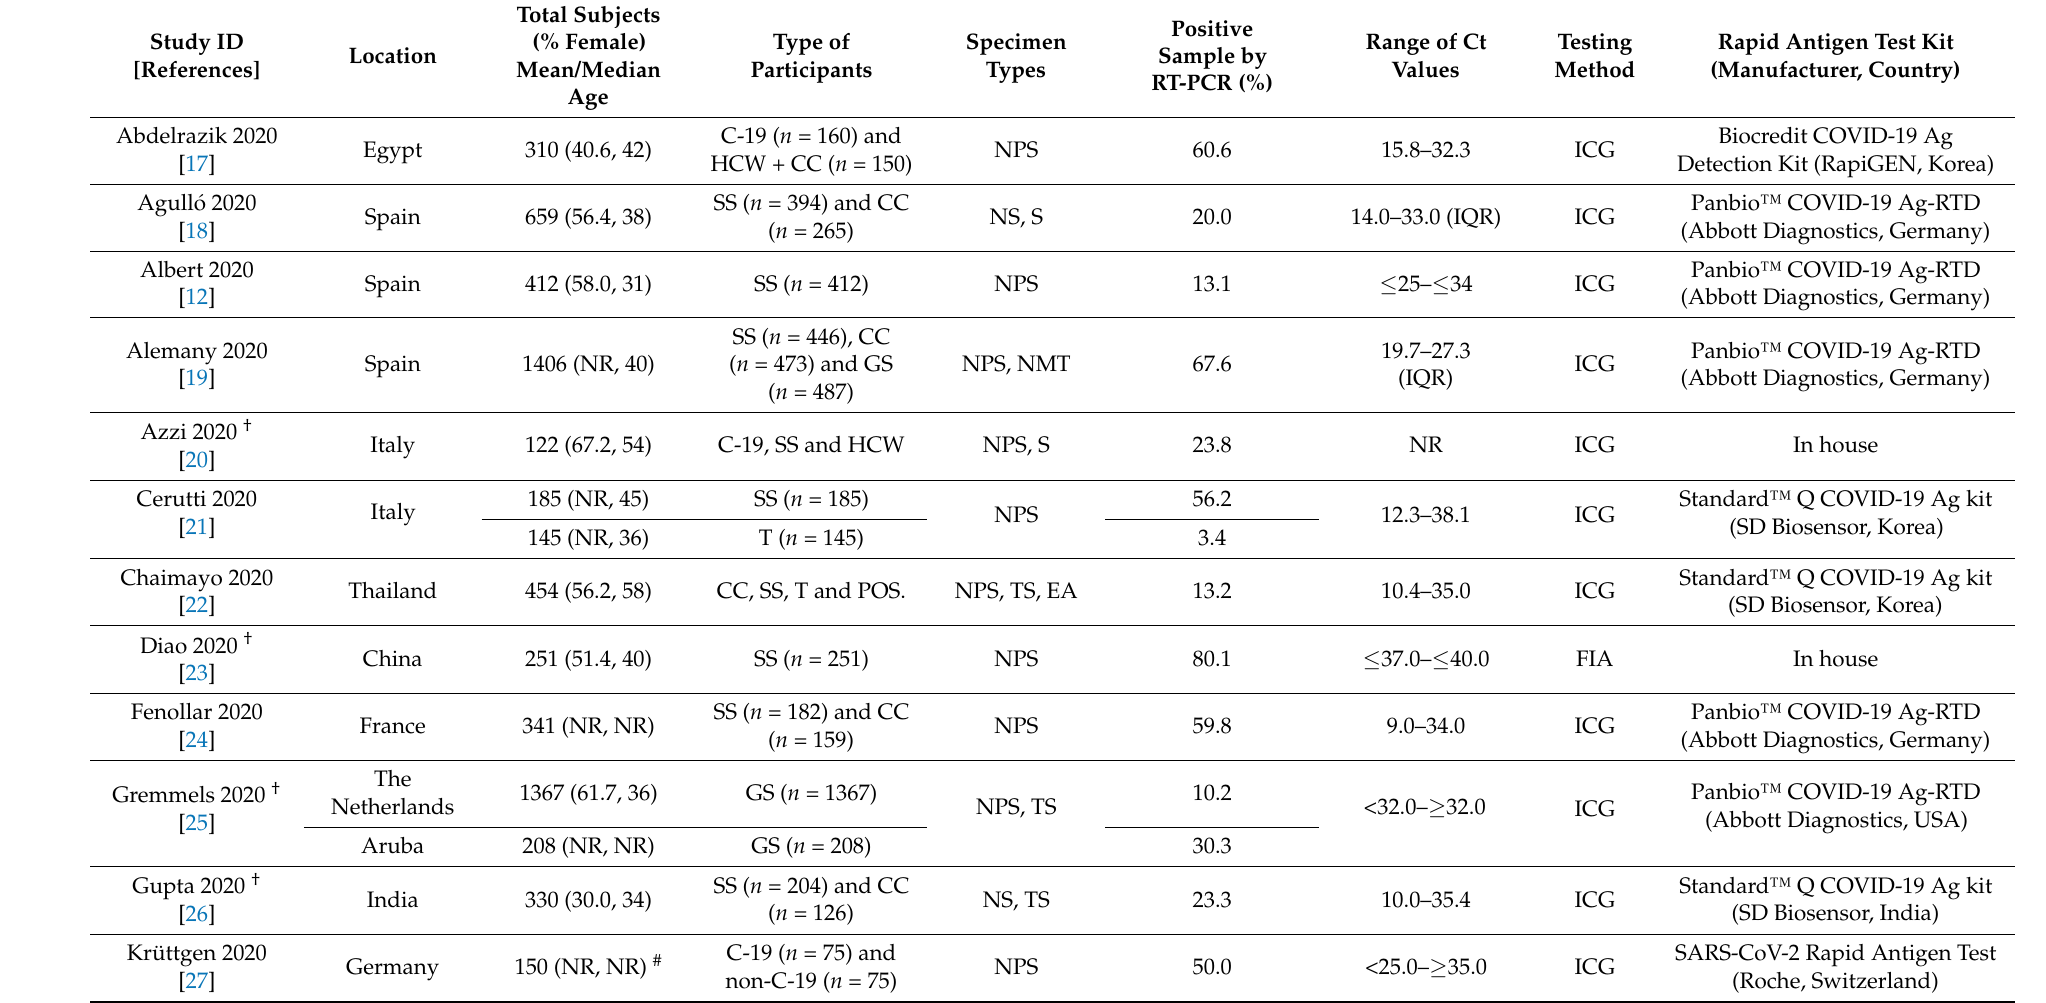
Table 1. Major characteristics of the included